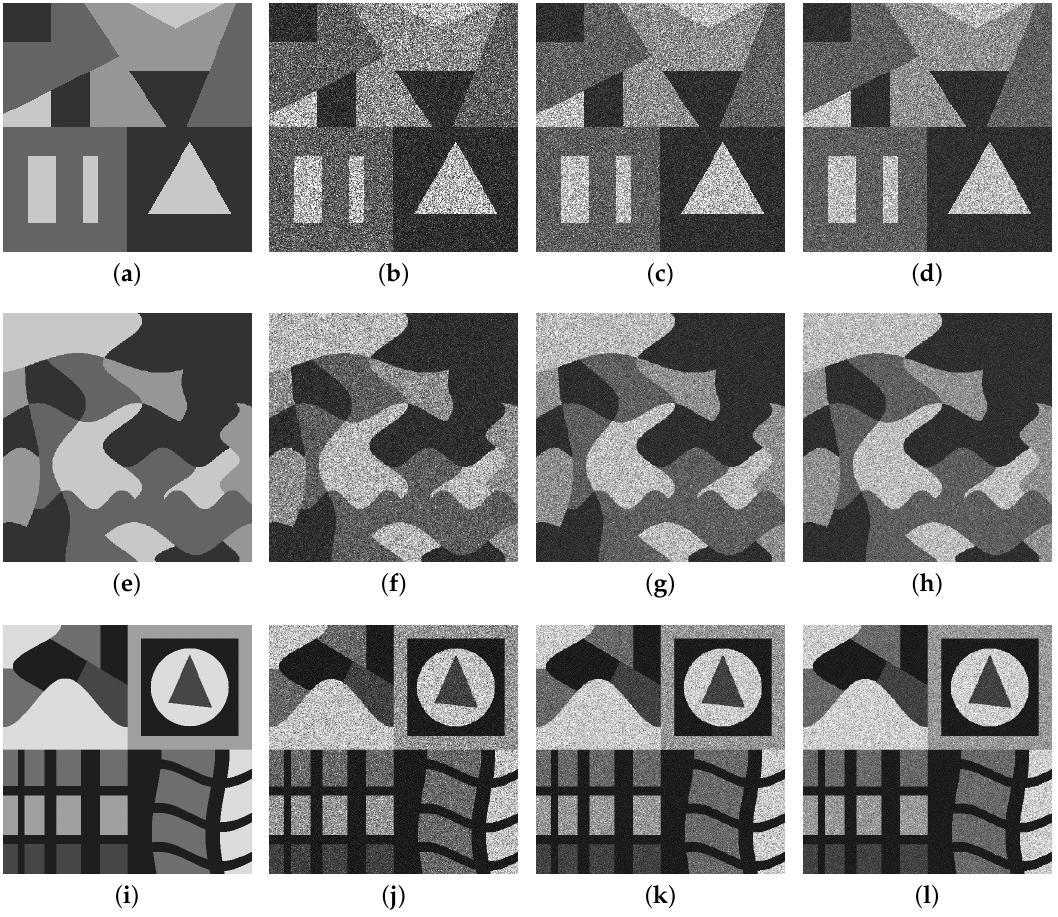
Figure 8. Simulated SAR images: ( a – d ) Original image, 2-, 4-, 6-look simulated SAR images of SI1; ( e – h ) original image, 2-, 4-, 6-look simulated SAR images of SI2; ( i – l ) Original image, 2-, 4-, 6-look simulated SAR images of SI3.